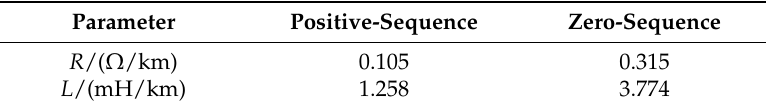
Table 1. Parameters of the AC